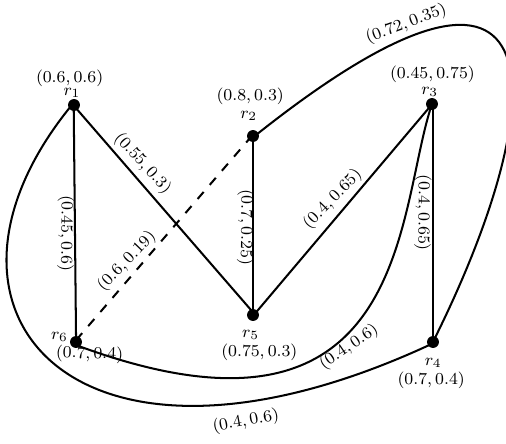
Figure 9. Pythagorean fuzzy planar graph with PF planarity Figure 4.2: Pythagorean fuzzy planar graph with PF planarity (0.53,0.65)